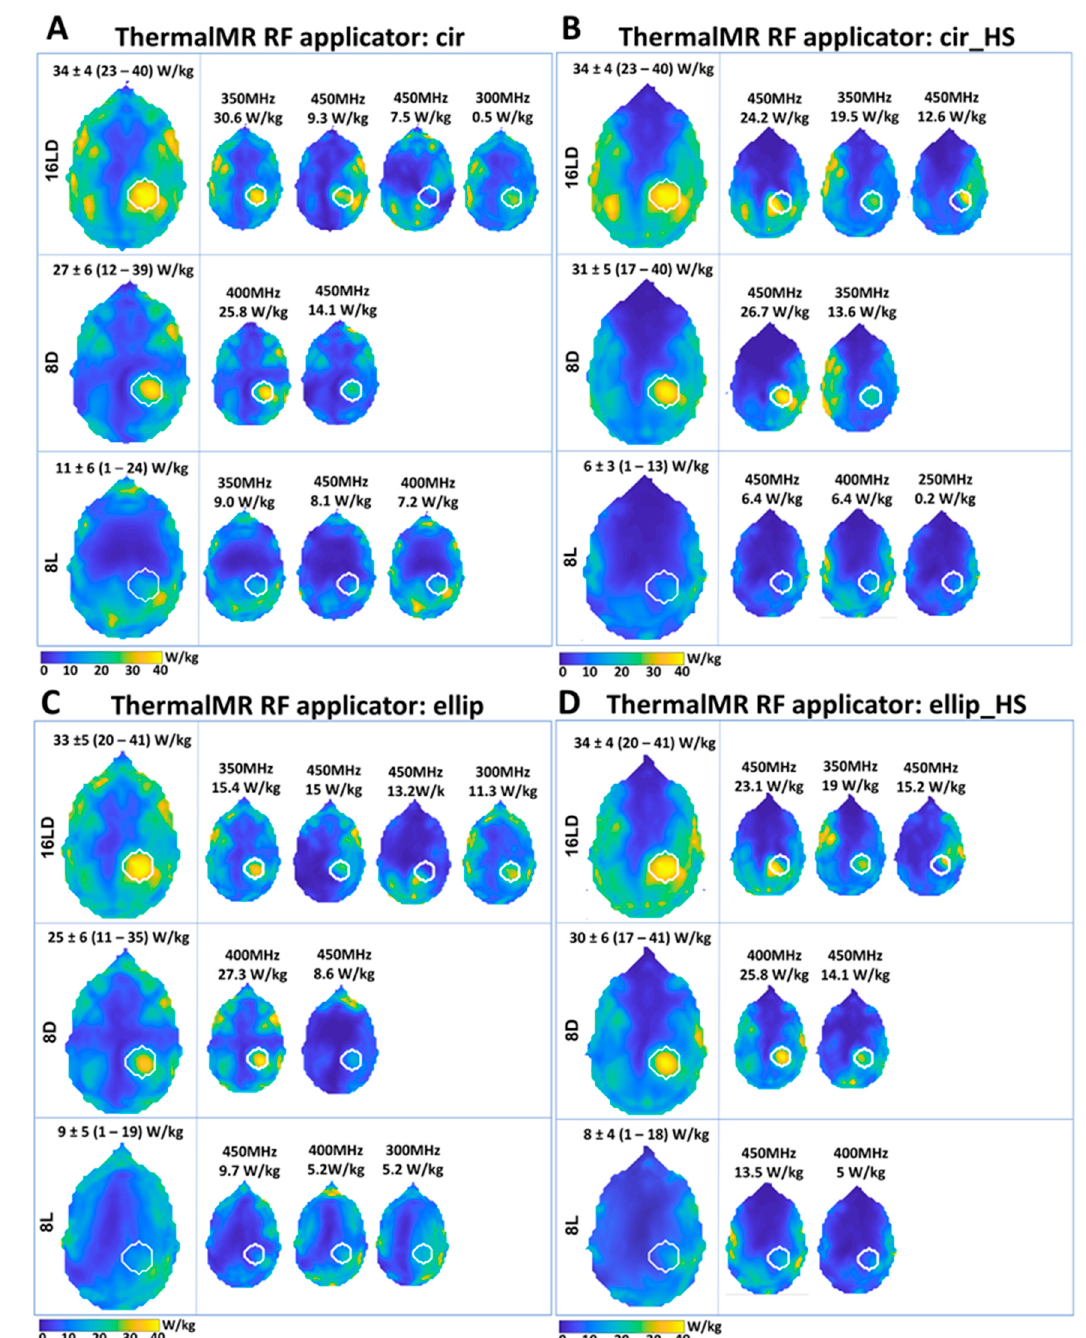
Figure 7. Optimization results obtained for targeted RF heating using the MVFS algorithm. Re- sults are shown for frequencies of 250, 300, 350, 400, 450 MHz on the head of the human voxel model Duke (axial slice) for each ThermalMR RF applicator (16LD, 8D, 8L) with the four variants: center; the targeted tumor region (TV) is depicted with a white line. The larger plots on the left of each panel shows the total achieved SAR 10g in the tumor TV (the mean ± SD and range (min–max value) is indicated above each plot. The resultant target pattern was created from the individual contributing time and frequency-multiplexed modes, shown in the smaller plots on the right sides of each panel (scaled to their individual maxima), with the respective peak contribution inside the tumor TV indicated